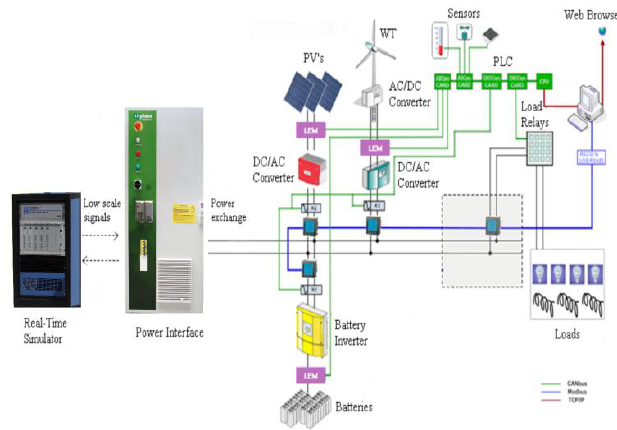
Figure 2. PHIL environment in NTUA Lab for DER devices.